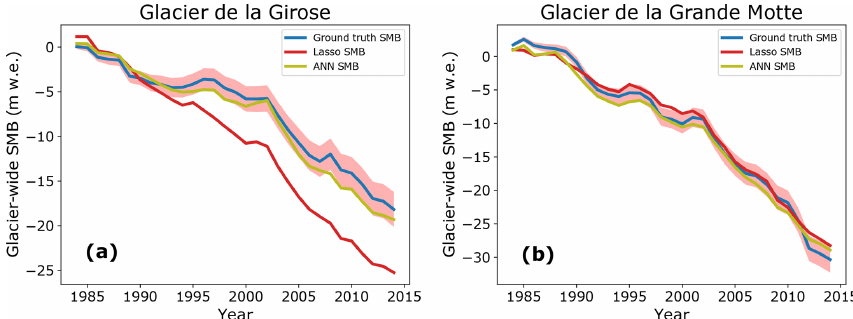
Figure 7. Examples of cumulative glacier-wide SMB (mw.e.) simulations against the ground truth SMB data. The pink envelope indicates the accumulated uncertainties from the ground truth data. The deep learning SMB model has not been trained with sample weights in these